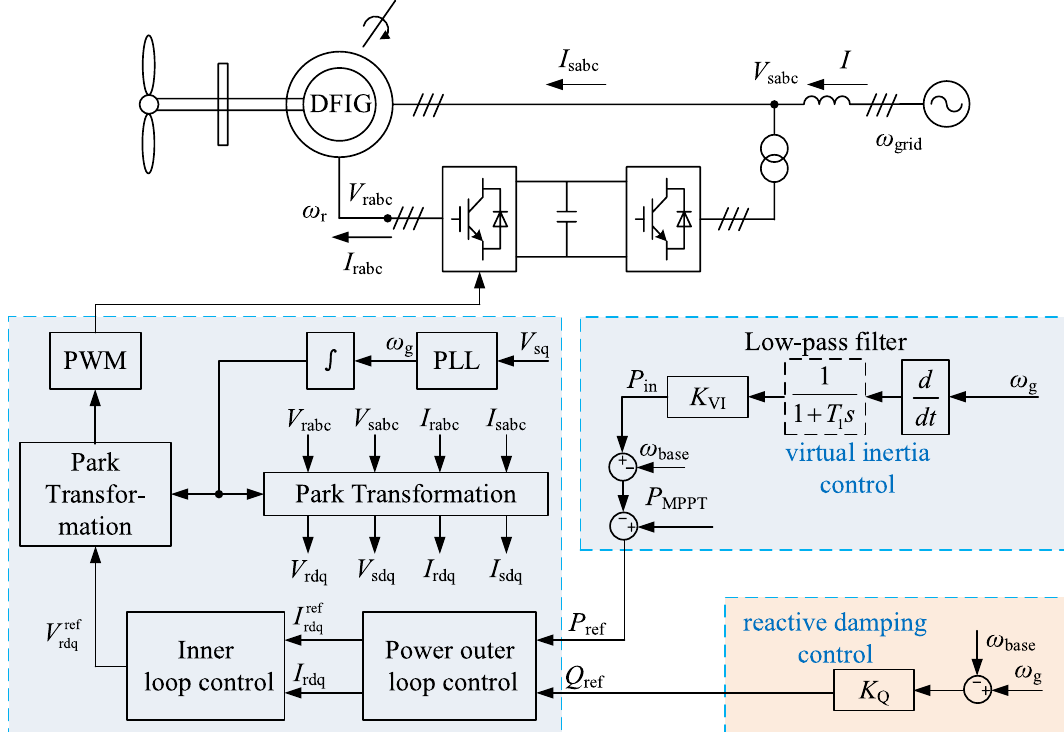
Figure 1. DFIG grid-connected system with damping and virtual inertia control